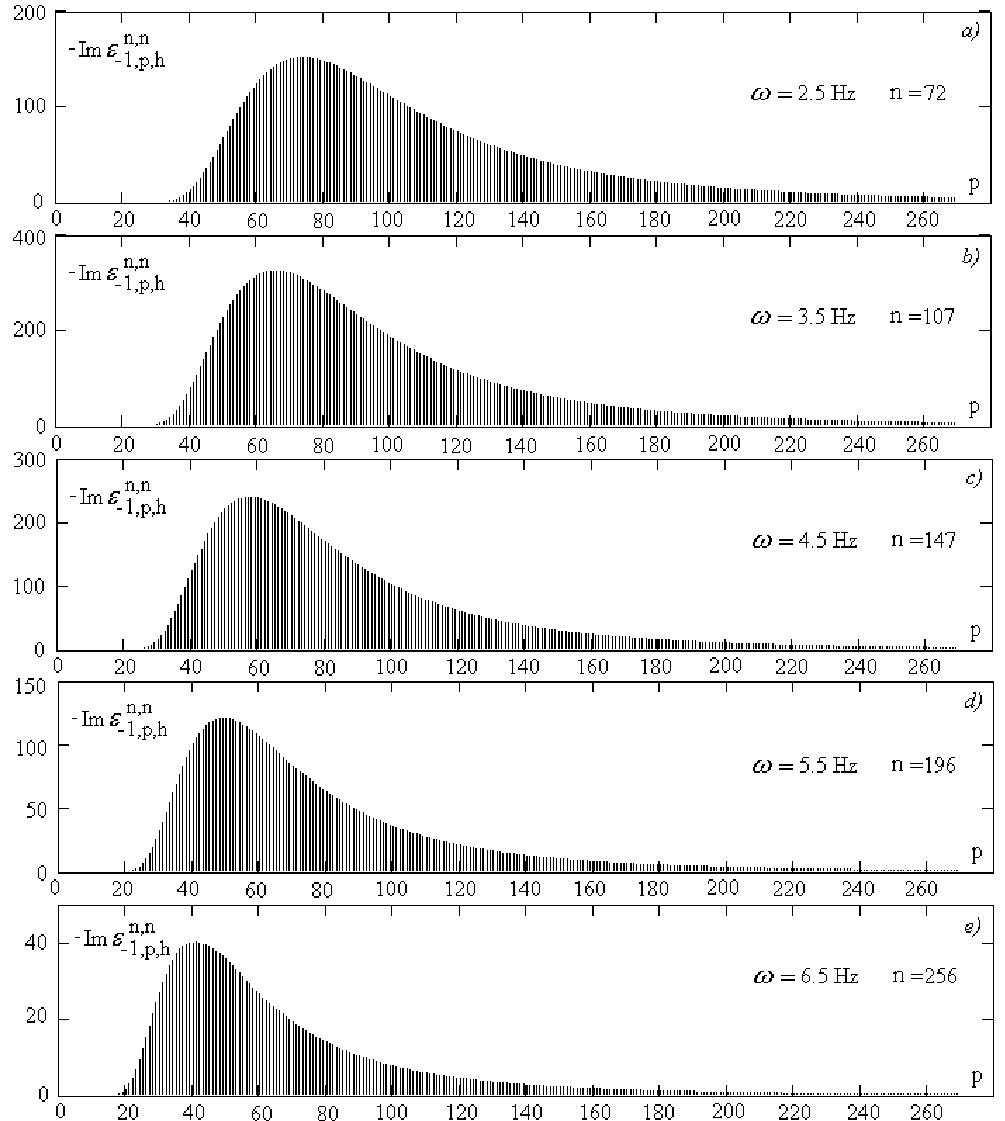
Fig. 5. The separate contributions of the bounce resonant terms to Im ε n,n − (c) ω =4.5Hz, (d) ω =5.5Hz, (e) ω